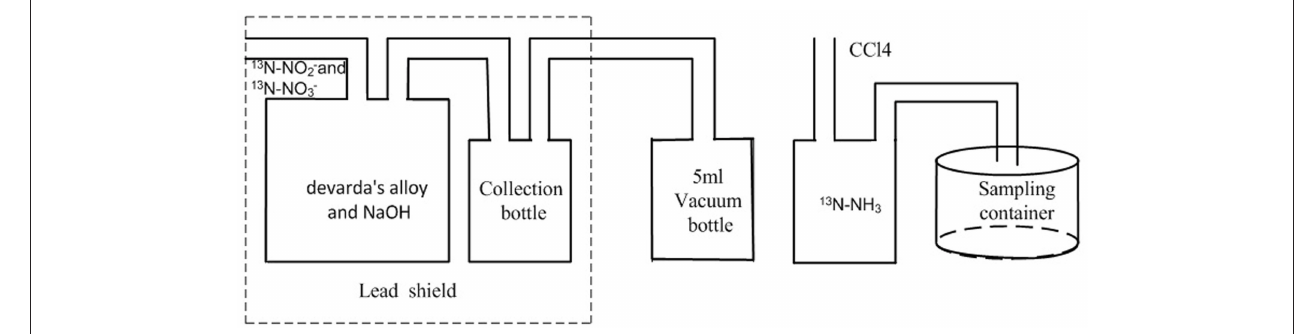
FIGURE 3 | Flow chart of the 13 N production.